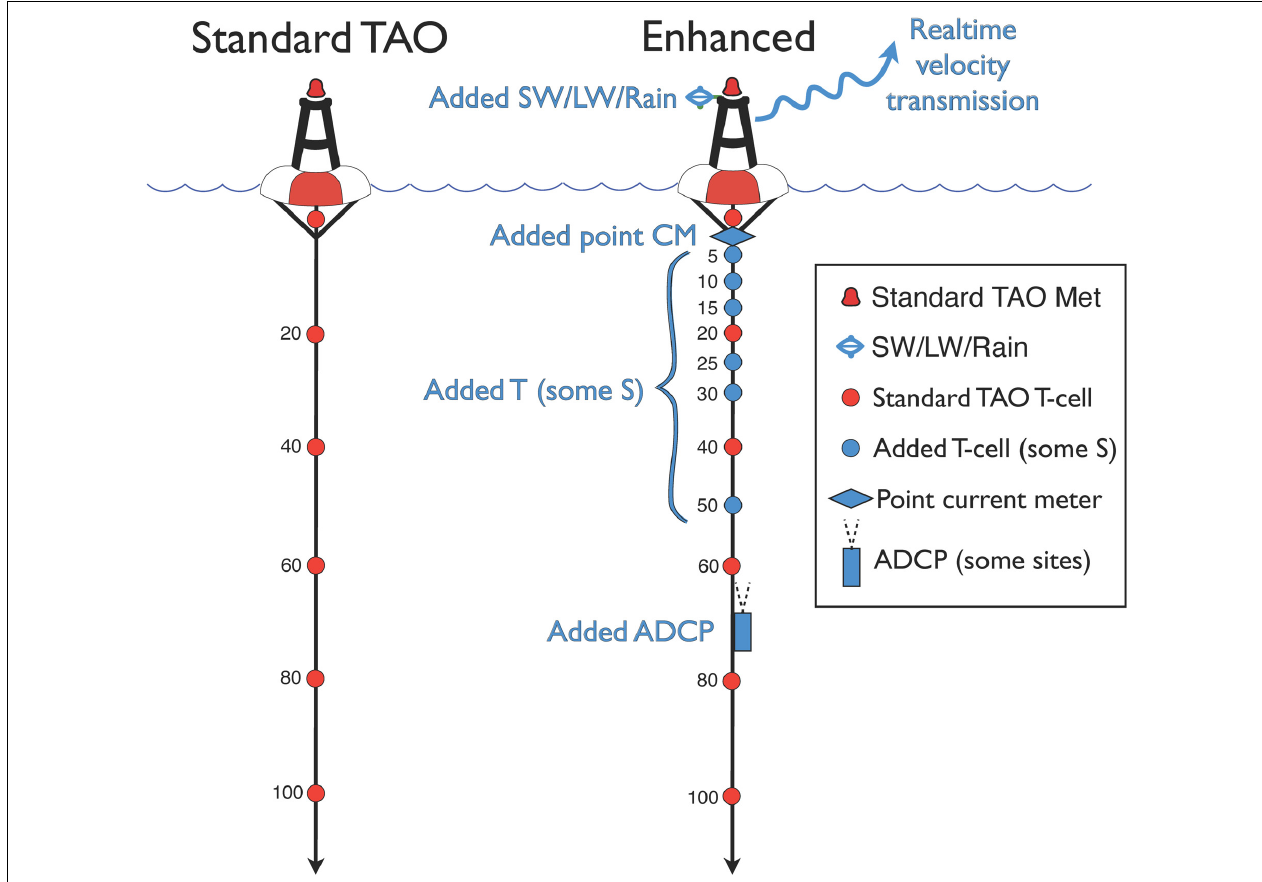
FIGURE 3 | Schematic of recommended enhancements to standard TAO moorings. Standard measurement suite shown in red; enhancements in blue. Depths (m) of the subsurface instruments are listed by each symbol. The enhancements are designed to provide quantities for bulk flux estimation and to take advantage of moorings’ high temporal sampling rates for the rapid-evolving, short-vertical-scale phenomena of the surface mixed layer, including velocity. Shallow velocity measurements are also needed to reference satellite scatterometer winds to the surface current, a particular problem in the tropics where currents are strong and winds relatively